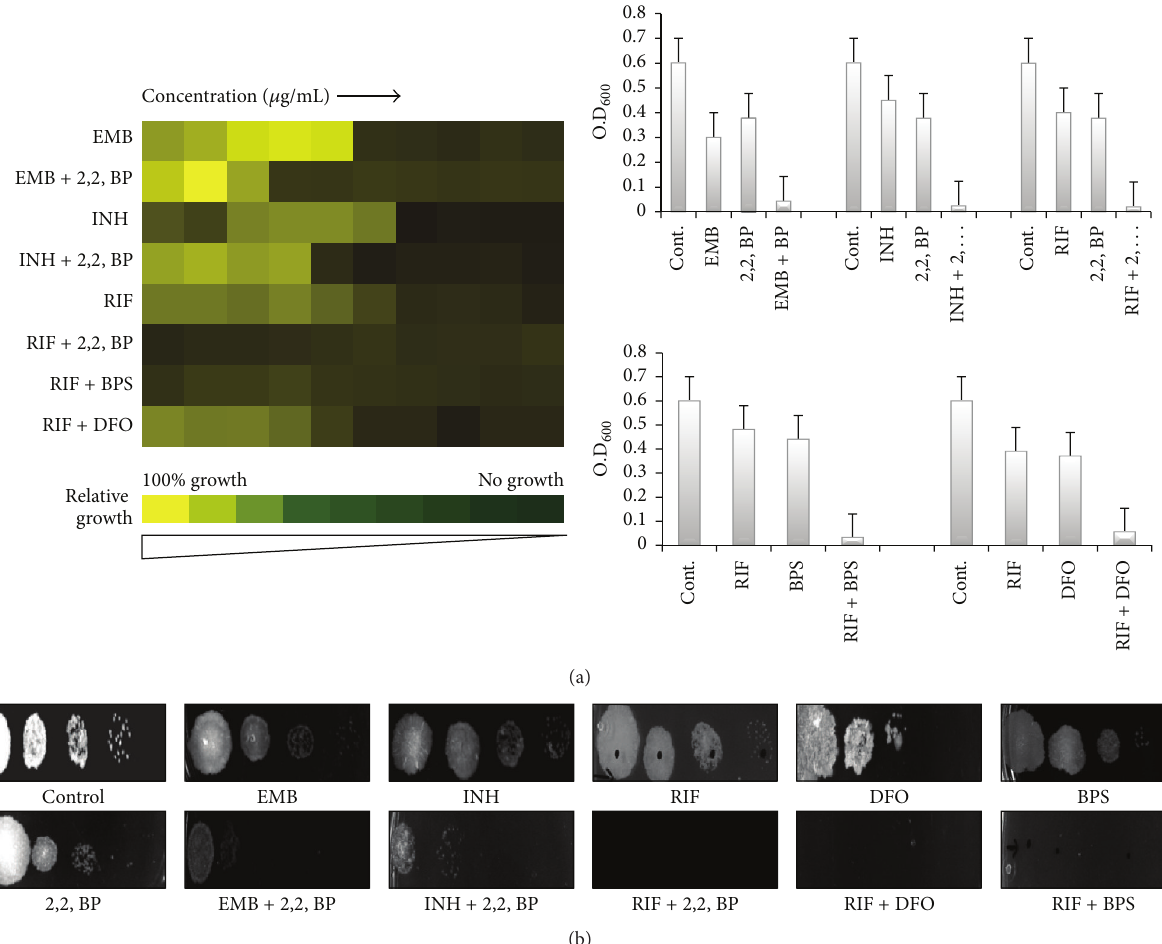
Figure 2: Drug susceptibility assays against M. smegmatis in response to iron deprivation. (a) Broth microdilution to determine the MIC 80 of M. smegmatis in the presence of EMB, INH, and RIF (62.5 ng/mL, 1 𝜇 g/mL, and 62.5 ng/mL) alone and in the presence of 2,2, BP, DFO, and BPS (35 𝜇 g/mL, 656 𝜇 g/mL, and 386 𝜇 g/mL), respectively, to determine the effect of iron deprivation on susceptibilities of EMB, INH, and RIF. Data was quantitatively displayed with color (see color bar in left panel), where each shade of color represents relative optical densities of the cell and as bar graphs (see right panel). The minimum drug concentration that inhibits growth by 80% relative to the drug-free growth control is indicated as MIC 80 for each drug. (b) Spot assays of M. smegmatis in the presence of EMB, INH, and RIF (62.5 ng/mL, 1 𝜇 g/mL, and 62.5 ng/mL) alone and in the presence of 2,2, BP, DFO, and BPS (35 𝜇 g/mL, 656 𝜇 g/mL, and 386 𝜇 g/mL) to confirm the effect of iron deprivation on susceptibilities of EMB, INH, and